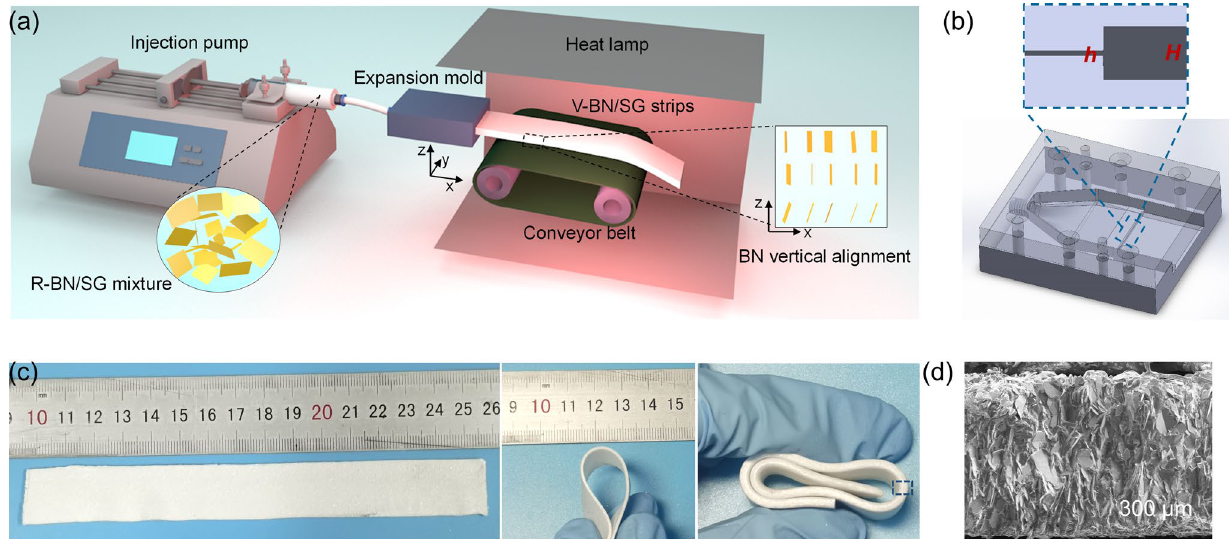
Fig. 1 Fabrication of flexible V-BN/SG strips featuring vertically aligned BN in the central area. a Schematic of the continuous fabrication of V-BN/SG strips, composed of the injection pump, expansion mold, conveyor belt, and heat lamp. b The expansion mold designed by the Solid- works software and the inset showing changed height of microchannels from small h to large H. c The prepared flexible V-BN/SG strips with controllable length and thickness. d SEM image of 60 V-BN/SG (0.2–2) strip (0.5 mm thickness) obtained by cutting off the top and bottom skin